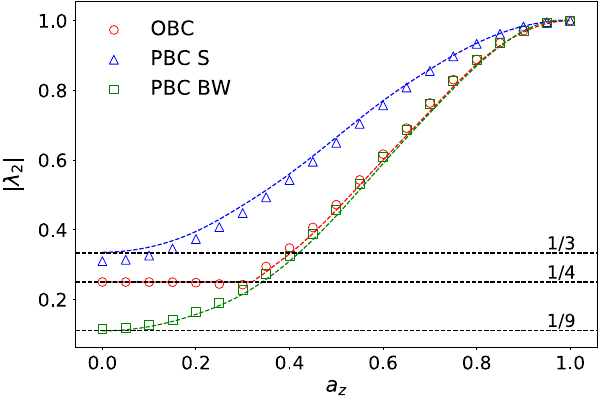
FIG. 6. Spectrally equivalent configurations for PBC protocols. In the example with n ¼ 8 , there are just four classes labeled by p ¼ 1 ; … ; 4 . The specific configuration shown in the left can be 3 Þ B ð 5 Þ p ¼ 3 transformed to S ð 1 with 6